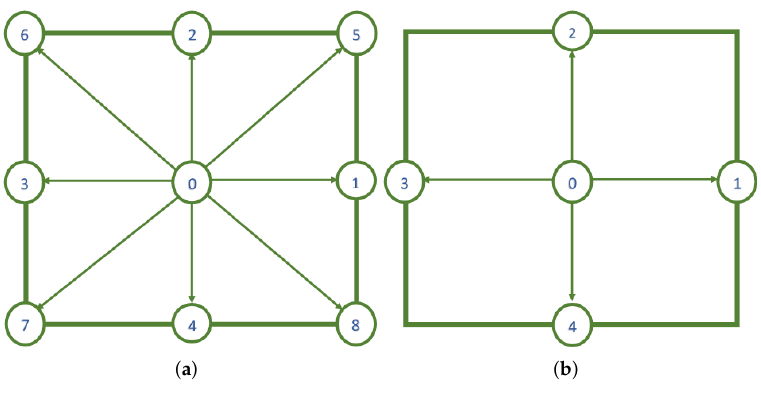
Figure 2. ( a ) D2Q9 and ( b ) D2Q5